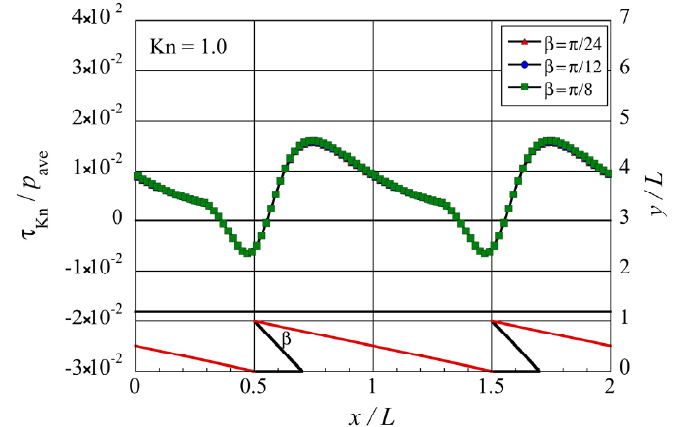
Figure 7. Net tangential Knudsen stresses, i.e., propulsive forces per unit area, at ( a ) different tip angles 𝛽 for the modified ratchet and ( b ) different inclination angles 𝛼 for the ratchet, for Kn = 1 .